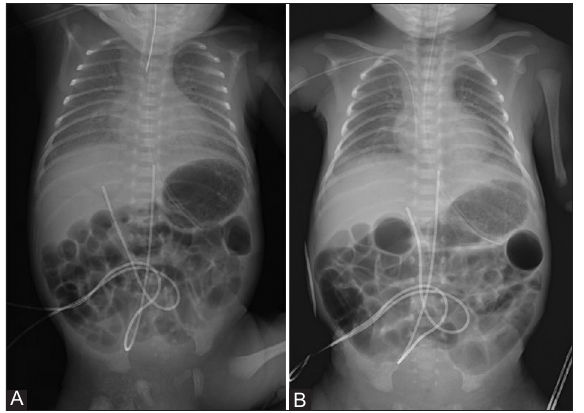
B FIGURE 1. (A) Frontal thoracoabdominal X-ray, previous dose of sur- FIGURE 2. (A) Frontal thoracoabdominal X-ray with pneumatosis intestina- lis in the lower right quadrant. (B) Lateral incidence, pneumatosis intestina- lis seen in frontal incidence, is corroborated.